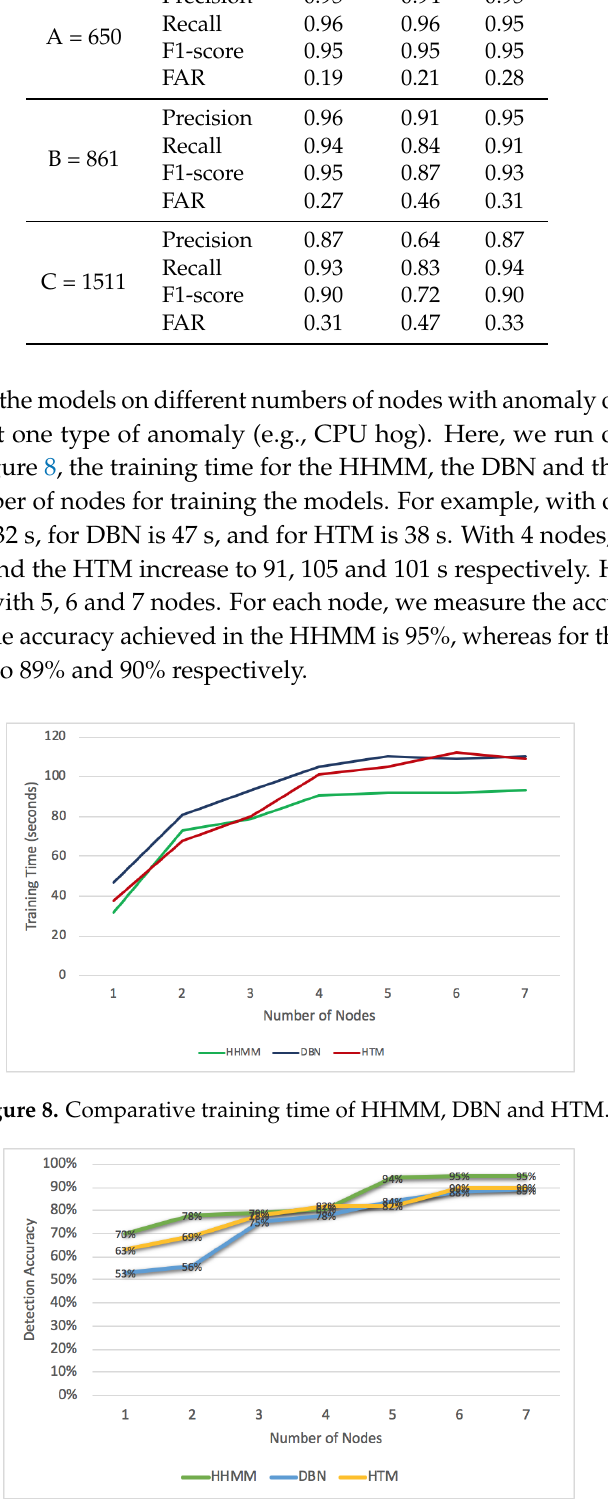
Figure 9. Comparative detection accuracy of HHMM, DBN and